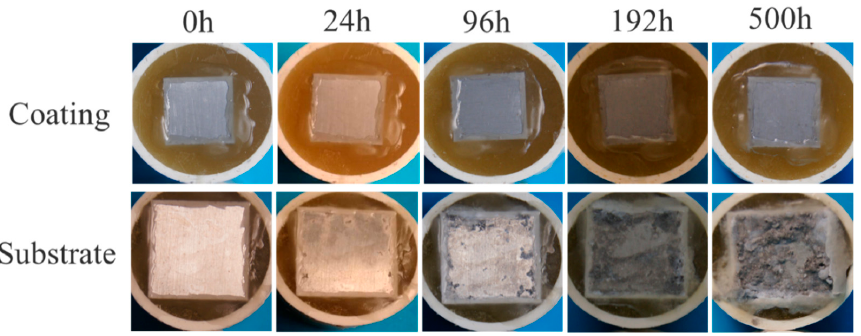
Figure 7. Photographs of the substrate and coating corroded surfaces after salt-spray testing for different times.